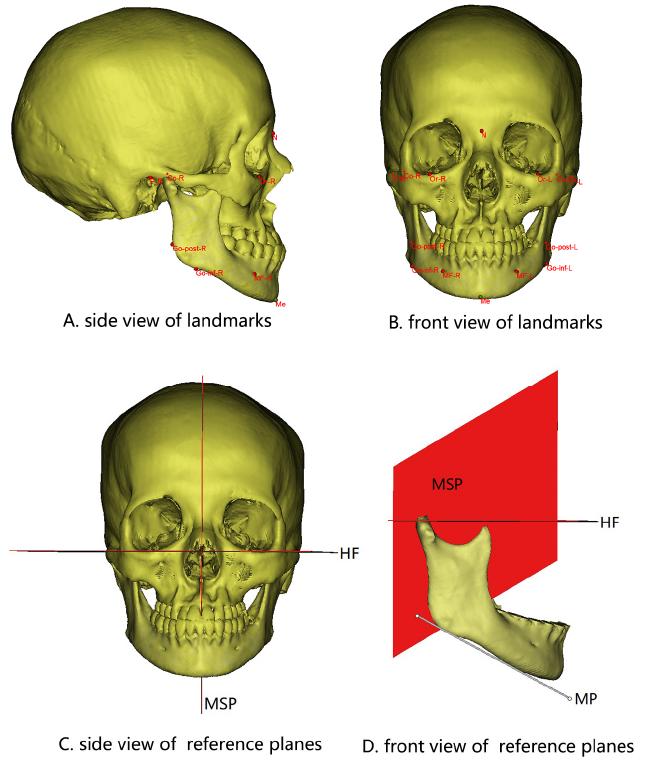
Figure 1. Landmarks ( A,B ) and reference planes ( C,D ) selected in this study. HF, Frankfort horizontal plane. MP, Tangent to the lowest part of the mandibular inferior border. MSP, Plane passing through N and Ba perpendicular to HF.